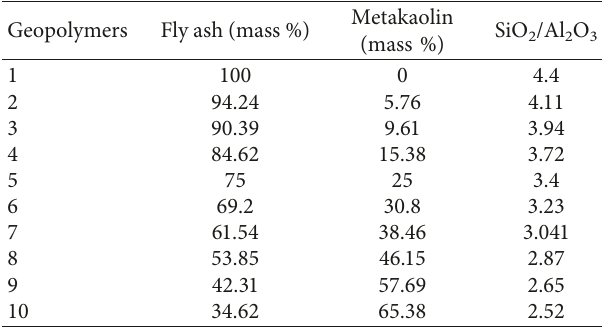
Table 1: Compositions formulated using fly ashes and metakaolin for obtaining geopolymers.